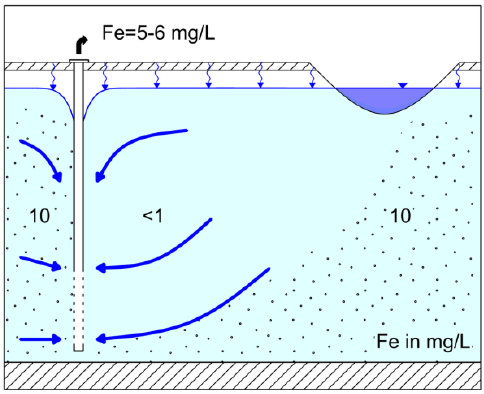
Figure 4. Case B – Infiltration of river water resulting low iron conc. in bank filtrate.